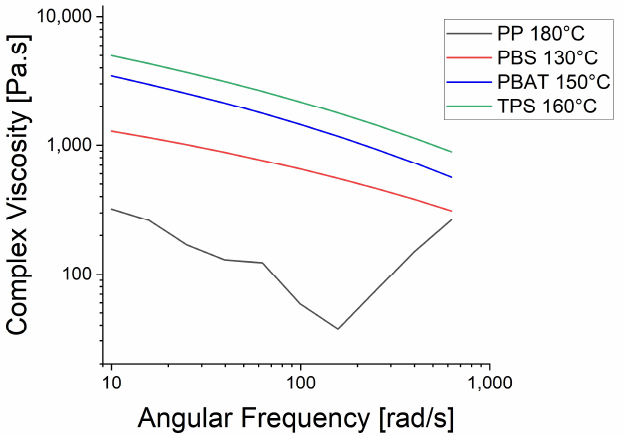
Figure 5. Rheology of four polymers at T m + 20 °C.